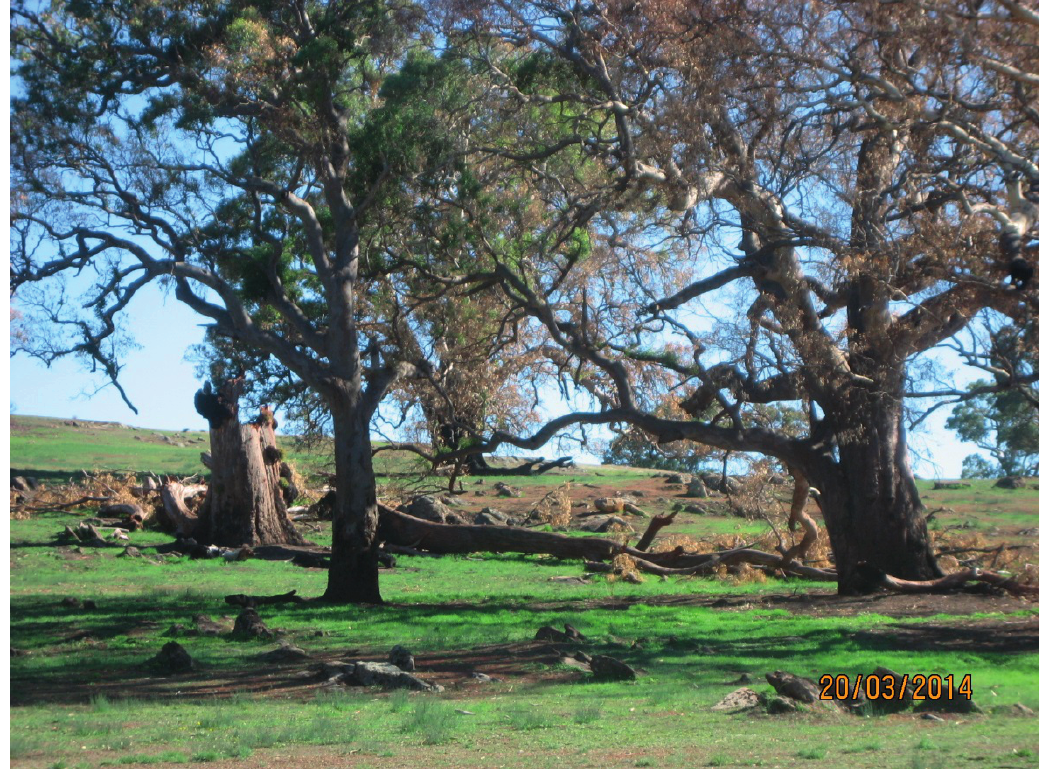
Figure 6. Grassy eucalypt woodland north-east of Adelaide in the Eden Valley fire area of January 2014. Note the apparent lack of tree regeneration across the pasture and the collapse of the tree on the left due to the fire (Photo: A. Malcolm